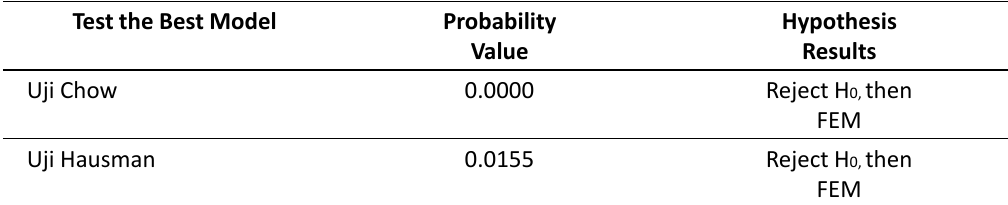
Table 4: Chow Test and Hausman Test